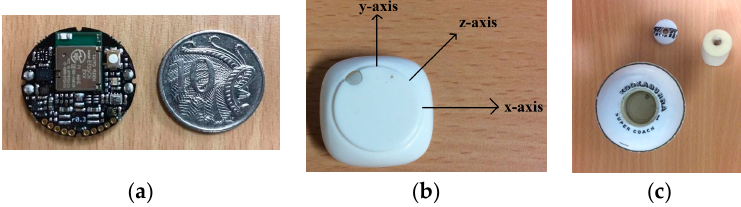
Figure 1. ( a ) MetaWear CPRO (mbientlab.com); ( b ) axes orientation on the MetaWear CPRO sensor placed inside a plastic case; ( c ) insertion of the sensor into the side of an indoor cricket